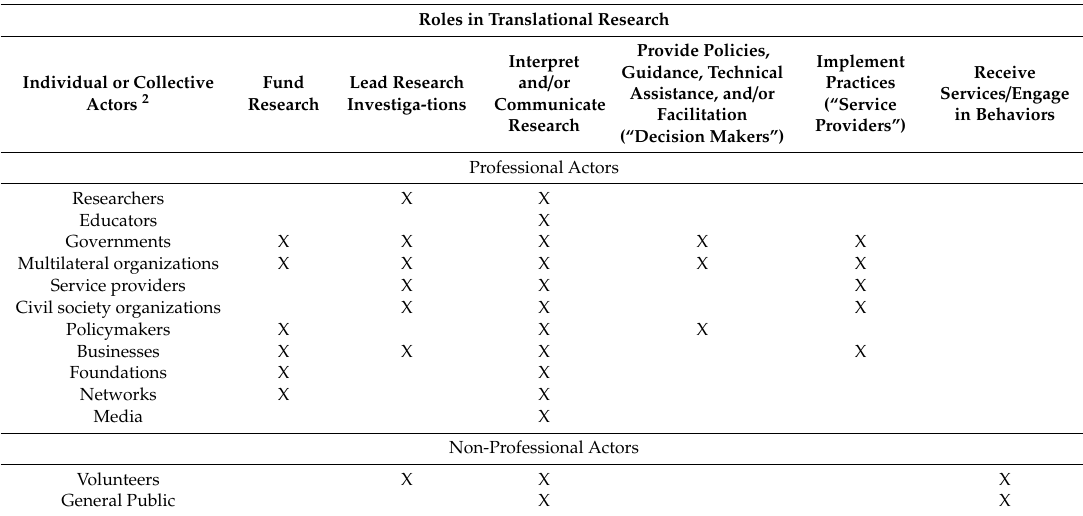
Table 1. Principal roles of water, sanitation, and hygiene actors in translational research 1